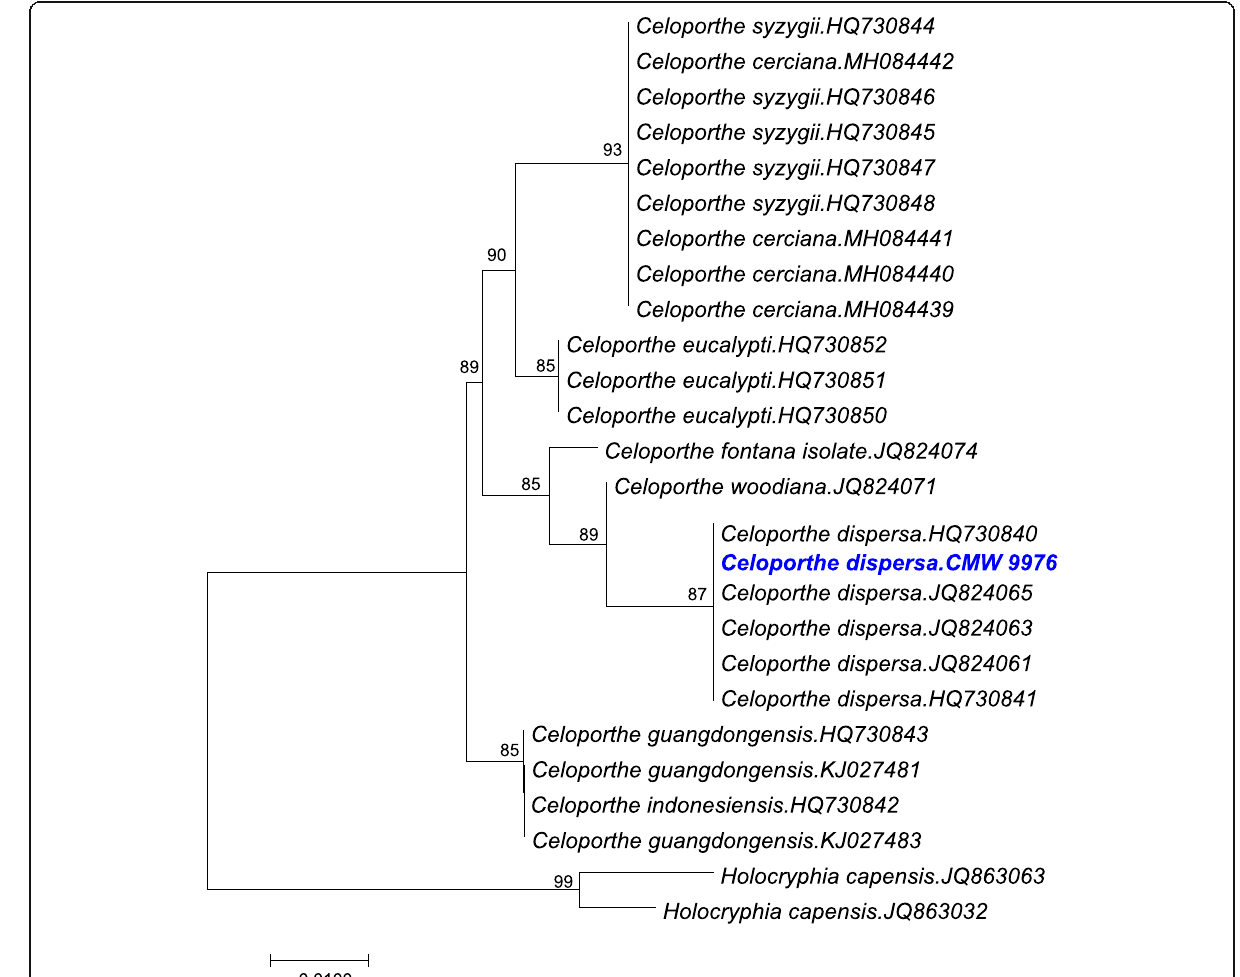
Fig. 2 Neighbor Joining (NJ) tree of the partial gene sequences of translation elongation factor 1- α of selected reference sequences of different Celoporthe species. Holocryphia capensis was used as an outgroup in our analysis. MAFFT version 7 (Katoh and Standley 2013) was used for making alignments. The phylogenetic analysis was conducted in MEGA 7 (Tamura et al. 2013). The optimal tree with the sum of branch length = 26.62500000 is shown. The percentage of replicate trees in which the associated taxa clustered together in the bootstrap test (1000 replicates) are shown next to the branches. The Celoporthe dispersa CMW 9976 isolate used in this study is shown in blue and